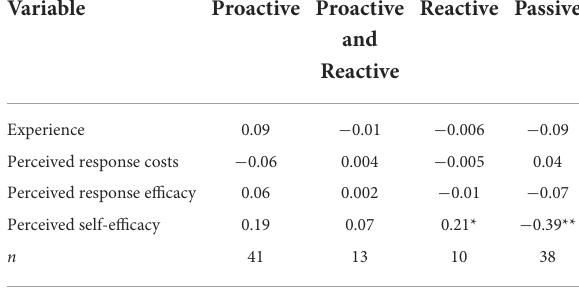
TABLE 5 Spearman-Rho-coefficients for possible drivers of precautionary behavior and adaptation strategies ( n = 102, data: businesses in Germany damaged by pluvial floods